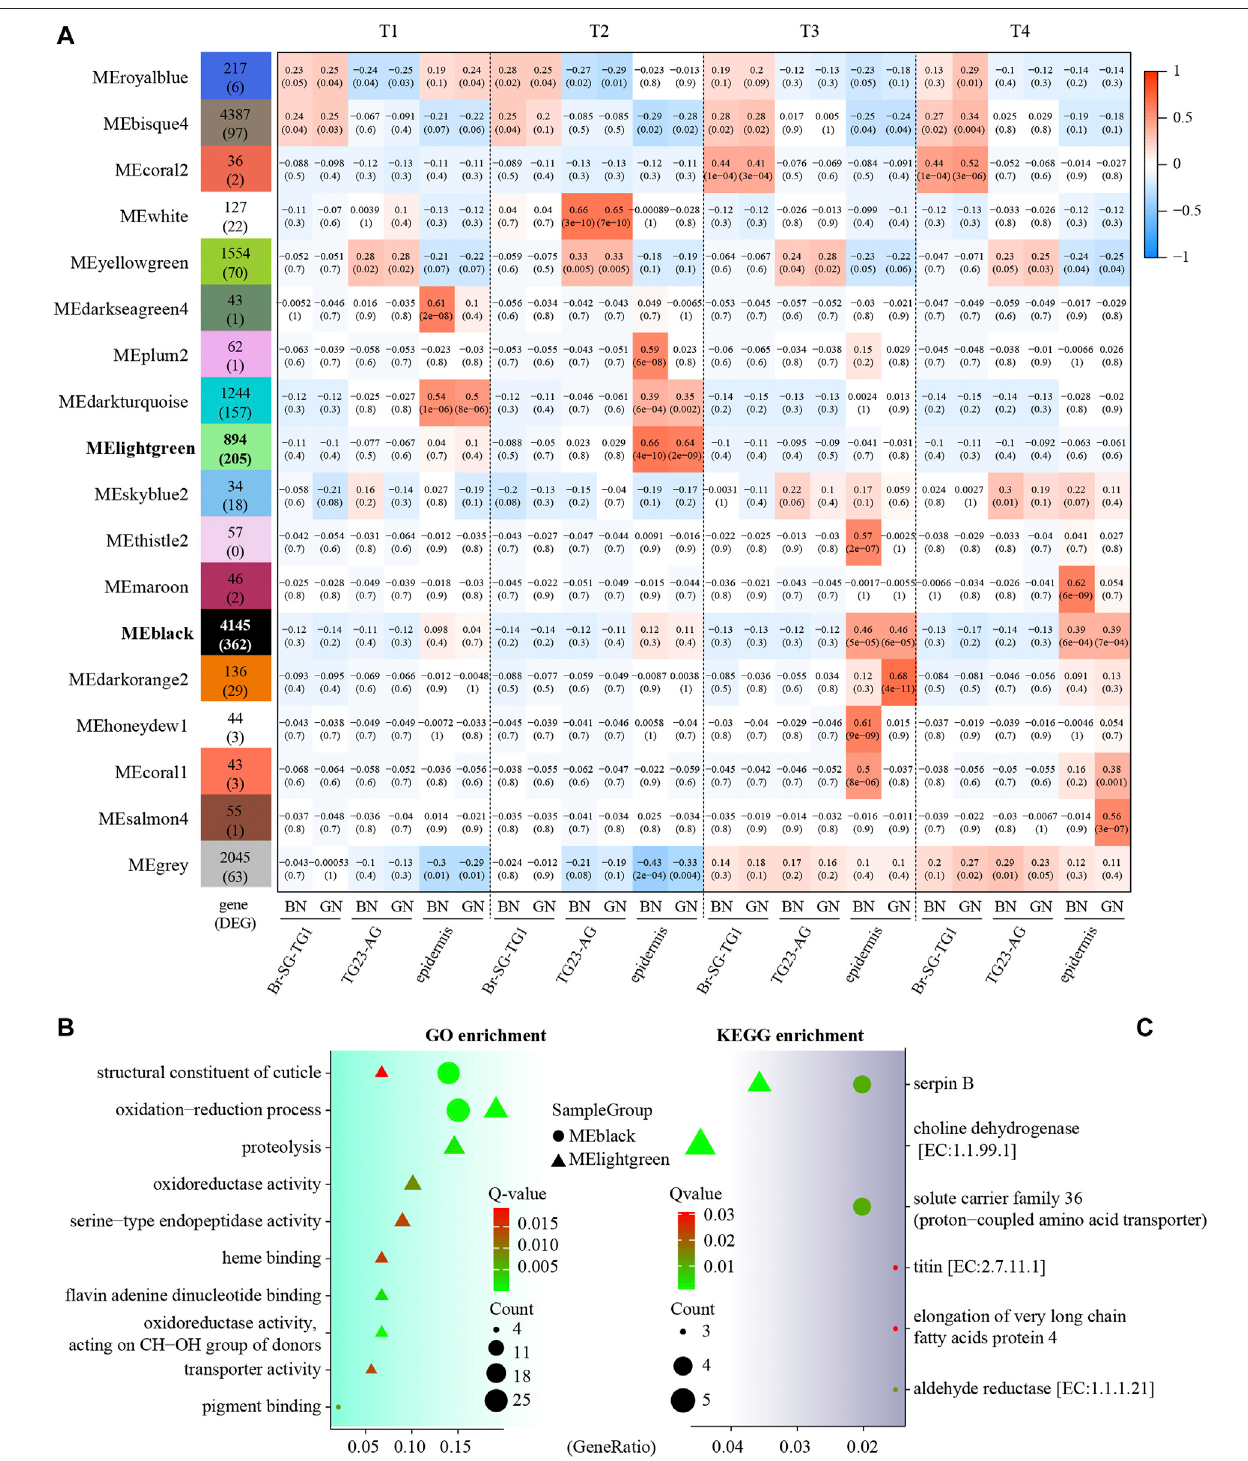
FIGURE 3 | Module-trait associations of expression pro fi les in three kind of tissues (Br-SG-TG1, TG23-AG, and epidermis) in Papilio xuthus pupa color formation under green and brown conditions using weighted correlation network analysis (WGCNA). (A) Each cell contains the corresponding correlation with the p -value in parentheses. Full information of tissues and periods refers to Figure 1 . The table is color-coded by the correlation according to the color legend. (B,C) GO and KEGG enrichmentanalysisofDEGsinMEblackandMElightgreenmodulesusingclusterPro fi lerpackage.GeneRatioistheratioofthenumberofgenesenrichedonGOor KEGG term to the number of genes input for enrichment